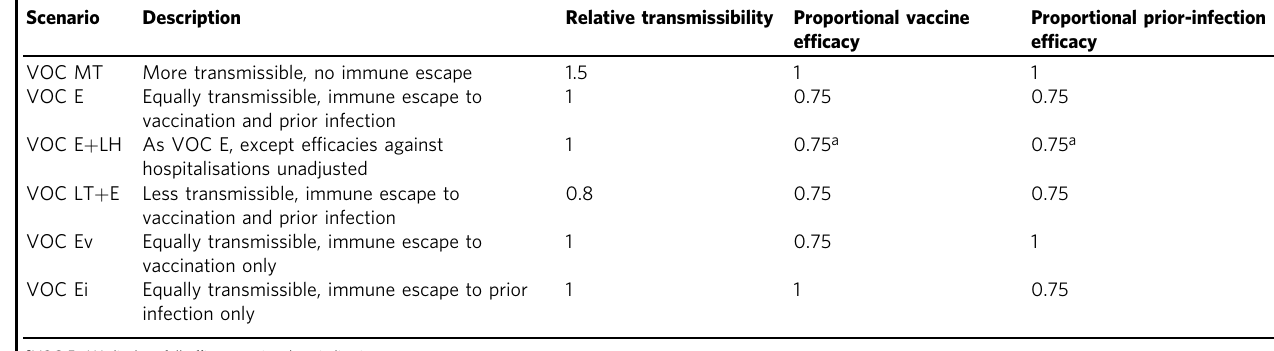
Table 1 Transmissibility and immune escape properties for putative Variants of Concern (VOCs). In the main analysis we consider four VOCs (VOC MT, VOC E, VOC LT + E, VOC E + LH), with results for two additional VOCs (VOC Ev and VOC Ei) presented in the Supplementary Information. For those previously infected by either the resident variant or the VOC, we assumed the prior-infection ef fi cacies towards the other variant were identical. Note that in the age-structured SARS-CoV-2 transmission model we also applied ef fi cacy scalings upon both symptomatic disease and hospitalisations (severe